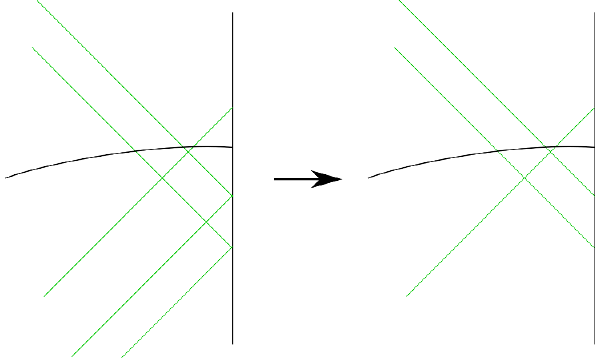
Figure 3 . Illustration of step 1, whereby we remove all shocks that do not cross (cid:6) t surface our operator lies in.